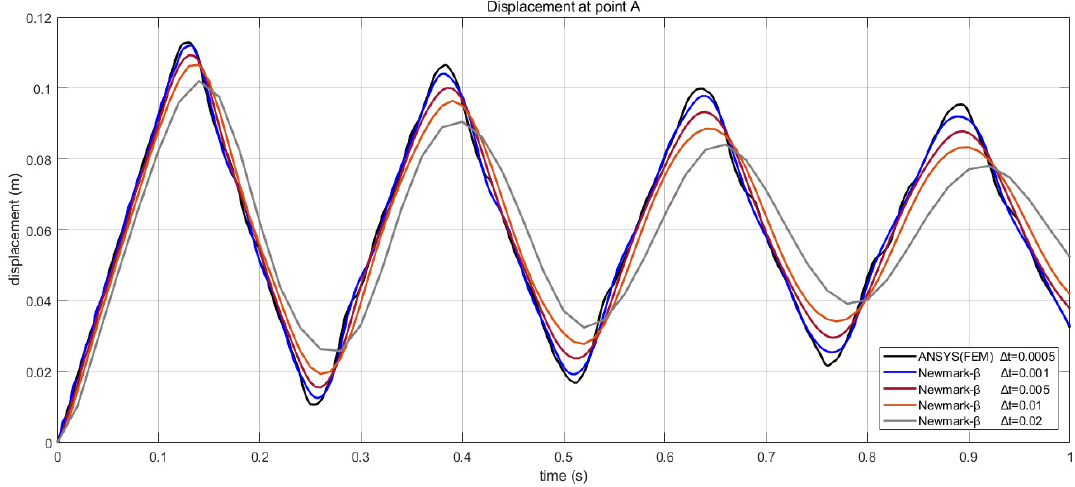
Figure 7. Displacements u x at point A using Newmark method with different time steps. ( α = 0.3, β = 0.6, 105 nodes with nodal distance d = 1.0 m ).